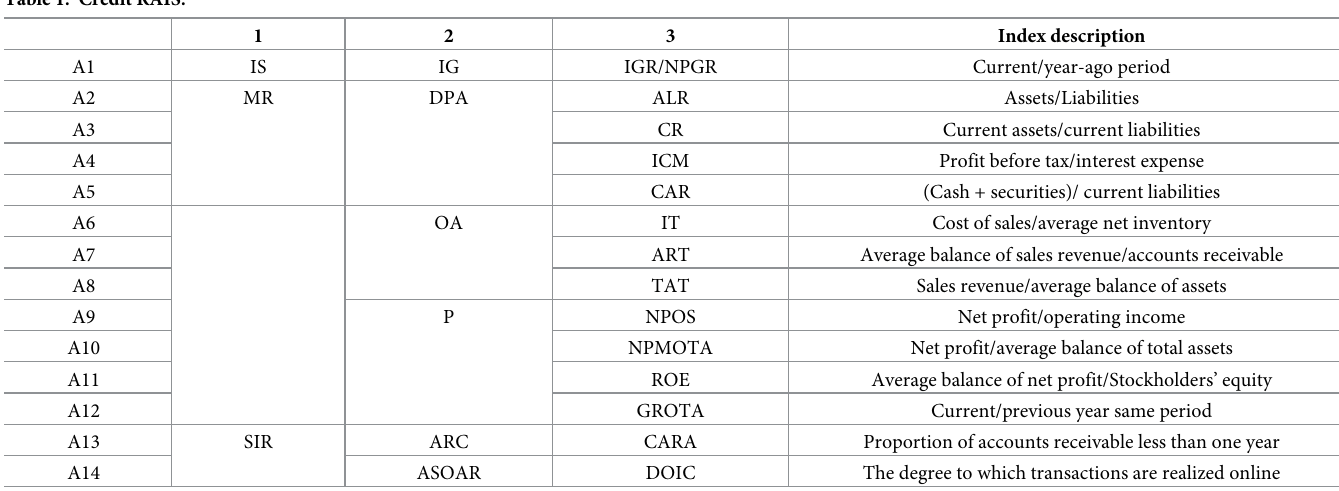
According to the relevant research, if the correlation between the two indexes surpasses 0.6, they have a high correlation. The paper conducts correlation analysis on the selected 14 indexes, of which the correlation e between the growth rate of NPMOTA and NPOS is 0.76, and the ICM and CAR have a high correlation of 0.843. Therefore, after the correlation analy- sis of 14 preselected indexes, the two indexes of NPMOTA and ICM, the number of indexes of the Internet-based SCF CRE system is 12.